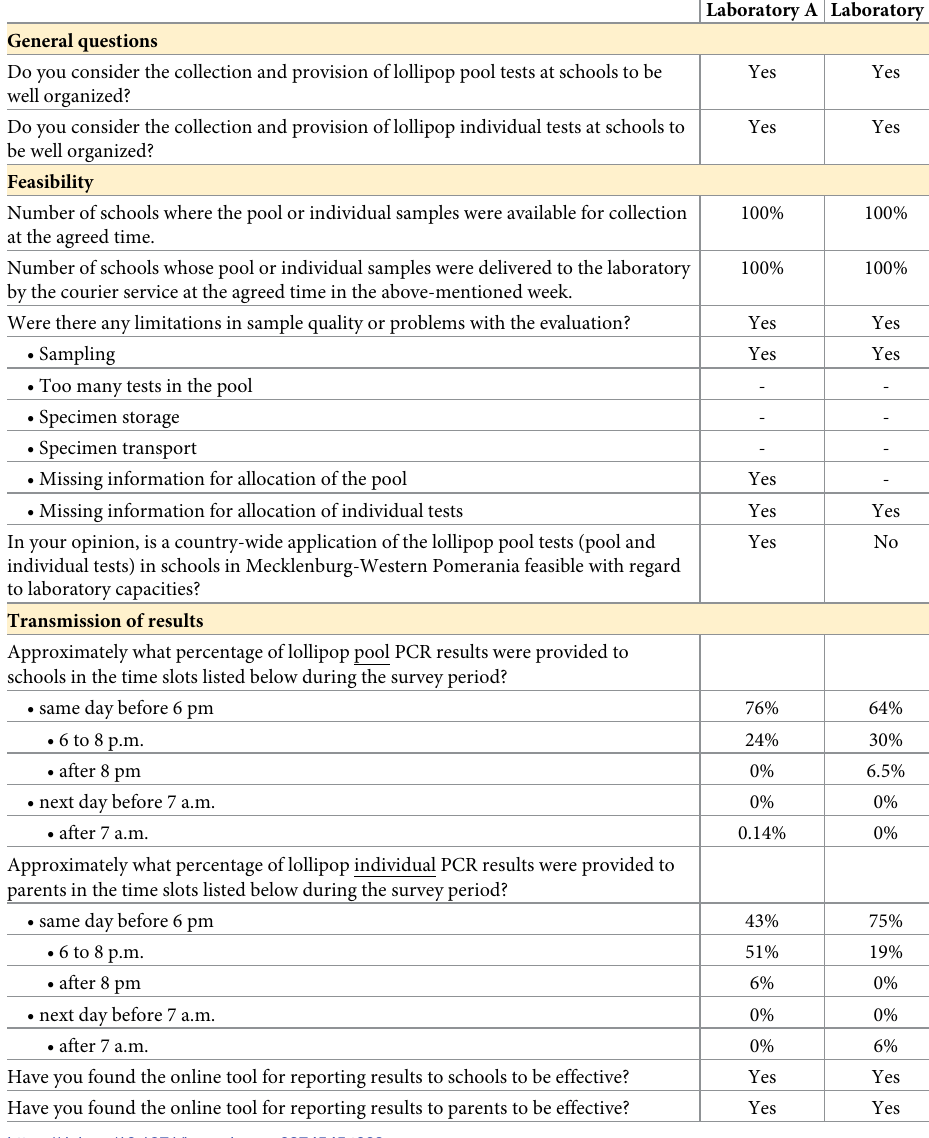
Laboratory A Laboratory B